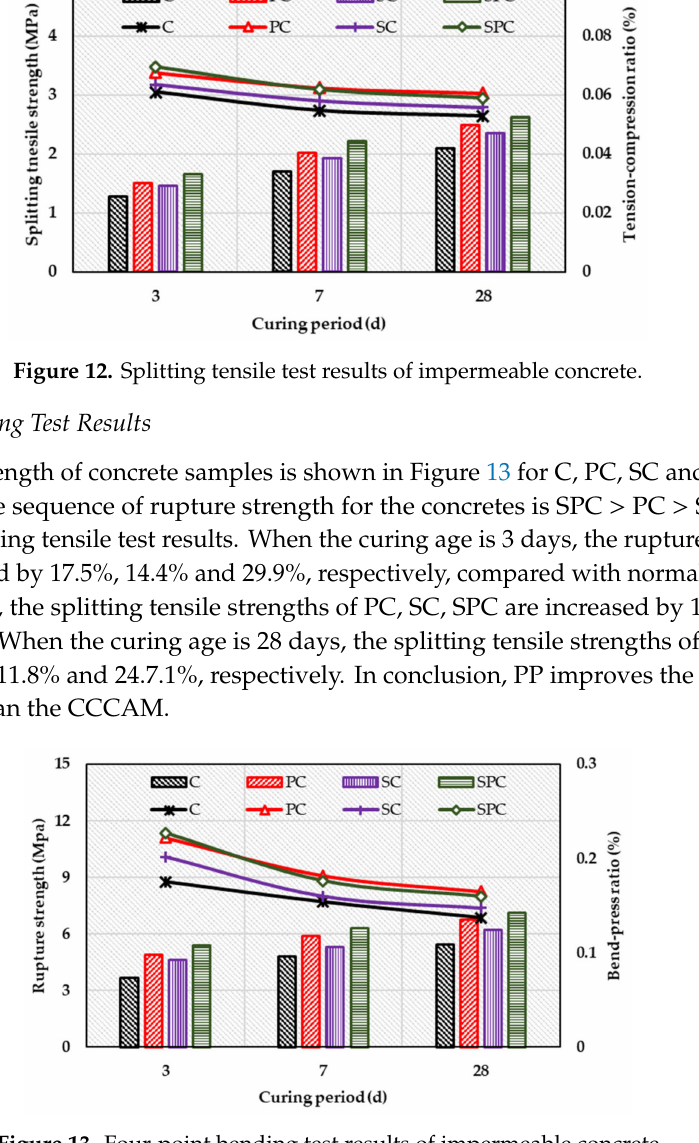
Figure 13. Four-point bending test results of impermeable